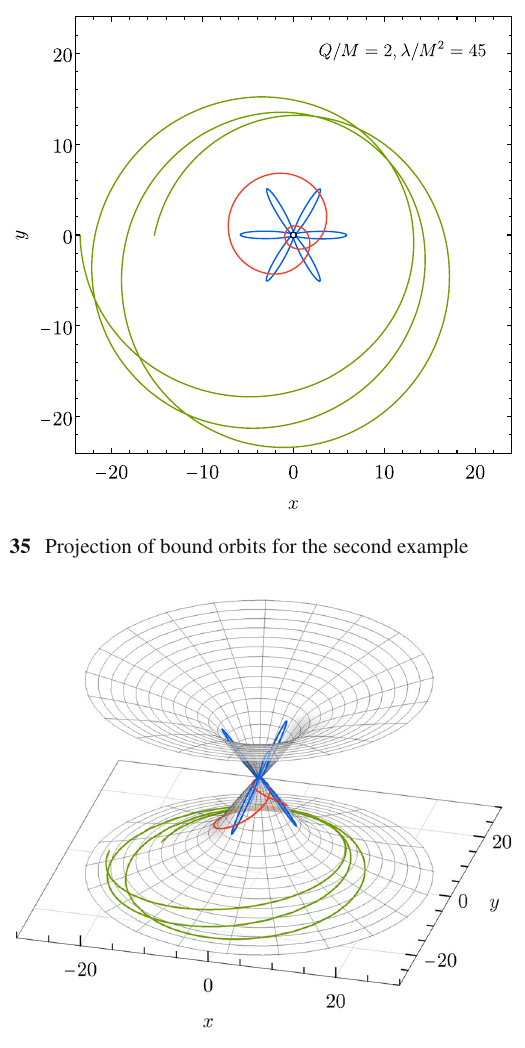
Fig. 36 3D view of the orbit of Fig. 35